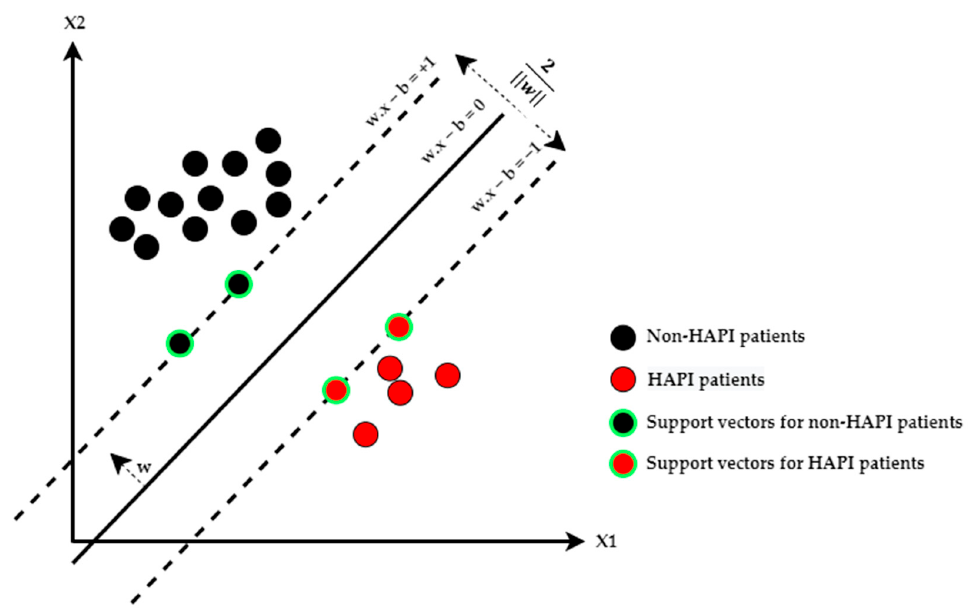
Figure 3. Having the optimal separation line means solving the mathematical optimiza- tion model below [39,40].